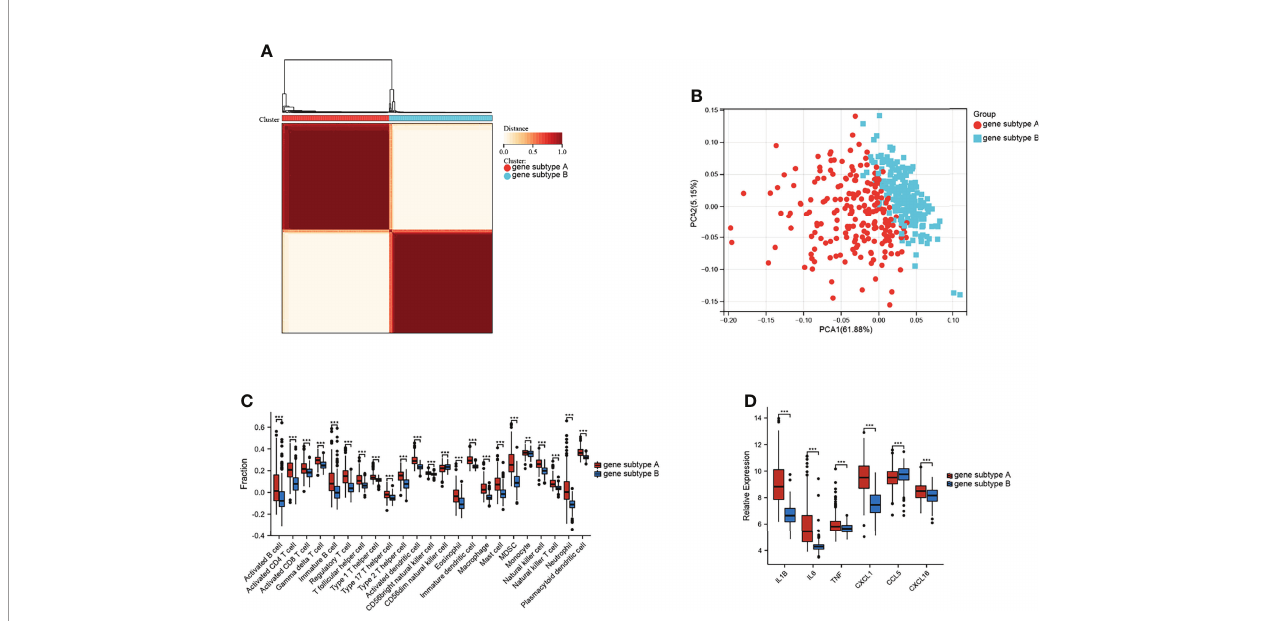
FIGURE 5 | Identi fi cation of gene subtypes. (A) Consensus clustering matrices of top 100 nodes in CD merged dataset (k = 2). (B) PCA for the expression of top 100 nodes to distinguish two genes subtypes in CD merged dataset. (C) In fi ltration fraction of immune cell in two genes subtypes. (D) mRNA expressions of CD- associated in fl ammatory factor (**p < 0.01 and ***p <